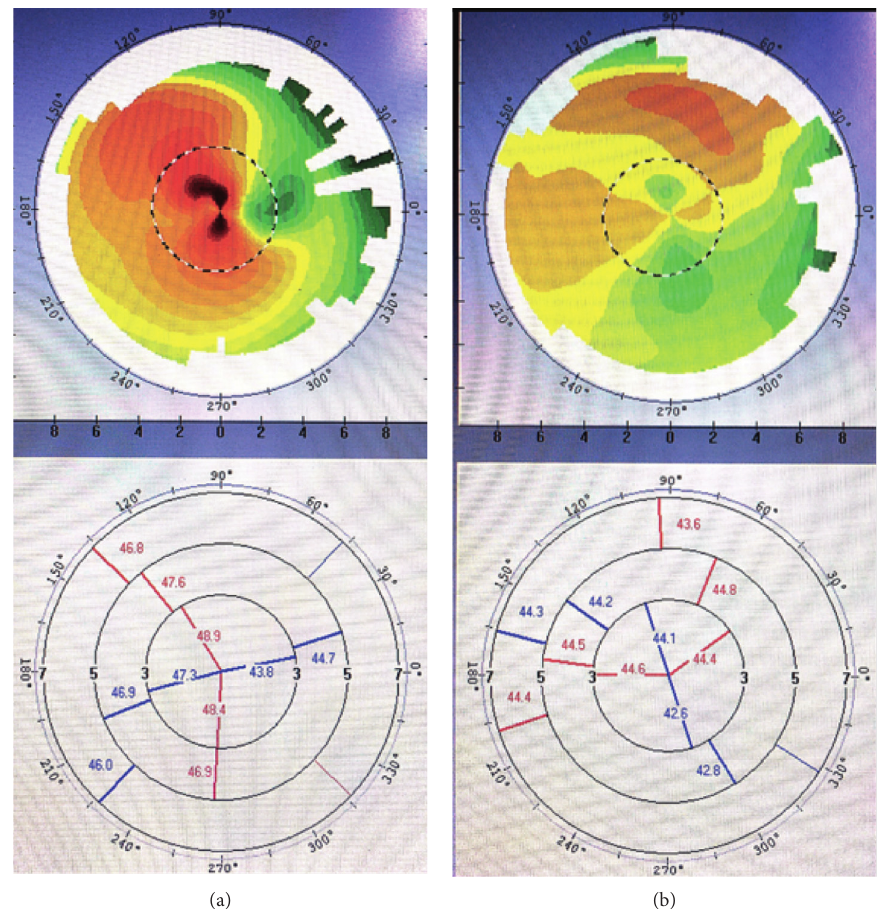
Figure 2: Corneal shape with an inclined hemimeridional pattern. (a, b) Two steep hemimeridional lines (in red) in the central 3-mm zone that do not belong to the same meridian and form an acute angle of 30–45 °